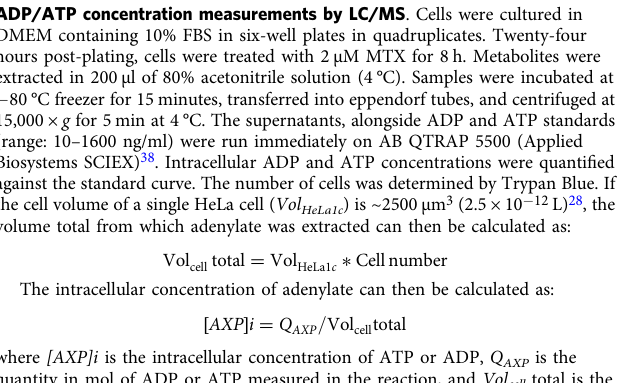
Fig. 5 Purine depletion triggers cell elongation and an EMT transcriptional program through an increase in cellular serine levels. a Representative images of actin cytoskeleton staining with Phalloidin (green) and nuclei (blue) from A375 cells treated with MTX (200 nM, 24 h) in the presence or absence of inosine (50 µ M, 24 h). Quanti fi cation of cell length from seven independent cells is presented relative to vehicle control. b As in ( a ), but from A375 cells that were treated with LTX (800 nM, 24 h) or AG2037 (100 nM, 24 h). c Relative mRNA expression of the indicated EMT markers upon treatment with MTX (200 nM, 24 h) in the presence or absence of inosine (50 µ M, 24 h). d As in ( a ), but from A375 cells that were treated with MTX (200 nM, 24 h) in the presence or absence of PHGDH inhibitor (PHGDHi, BI-4924, 15 µ M, 24 h). e Relative mRNA expression of the indicated EMT markers upon treatment with MTX (200 nM) in the presence or absence of PHGDH inhibitor (PHGDHi, BI-4924, 15 µ M, 24 h). f Relative mRNA expression of the indicated EMT markers as in c , but from wild-type or Δ PHGDH A375 cells treated with either vehicle (DMSO) or MTX (200 nM, 24 h). g As in ( a ), but from A375 cells that were treated with MTX (200 nM, 24 h) in the presence or absence of TEPP-46 (100 µ M, 24 h). h As in ( a ), but from A375 cells that were treated with serine (400 nM, 24 h) or Formate (2 mM, 24 h) in normal DMEM media. i Relative mRNA expression of the indicated EMT markers upon treatment with serine (400 nM, 24 h) or Formate (2 mM, 24 h) in normal DMEM media. a – i Data are presented as the mean ± s.d from n = 3 ( c , e , f , i ) or n = 7 ( a , b , d , g , h ) of biologically independent samples. a – i One-way ANOVA, Turkey ’ s post-hoc test, multiple comparison * p <